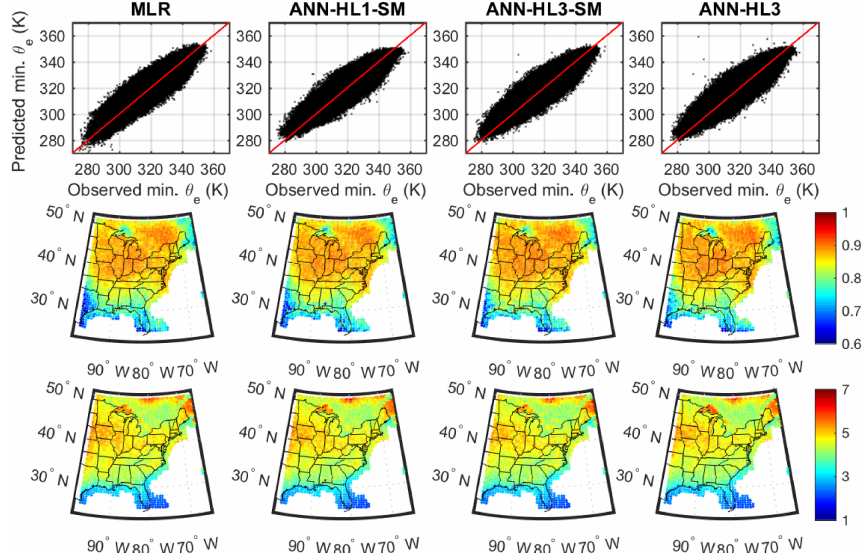
Figure 5. Précis of the downscaling model performance for daily minimum θ e (min. θ e ). The upper panels show scatter plots of observed and predicted minimum θ e for all grid cells and all days within the test (independent) data, along with a red 1:1 line. The columns show results for four model configurations: multiple linear regression (MLR, left), ANN with one hidden layer (ANN-HL1-SM, second column), ANN with three hidden layers (ANN-HL3-SM, third column) and ANN with three hidden layers but excluding information regarding the soil moisture (ANN-HL3, right column). The second row shows the Pearson correlation ( r ) of predicted and observed minimum θ e values in the independent data for the four different models, while the third row shows the mean root mean square error (RMSE) (K) computed for independent data from each grid cell for the four models. Results for ANN-HL3-TOP are virtually identical to those for ANN-HL3-SM and thus are not